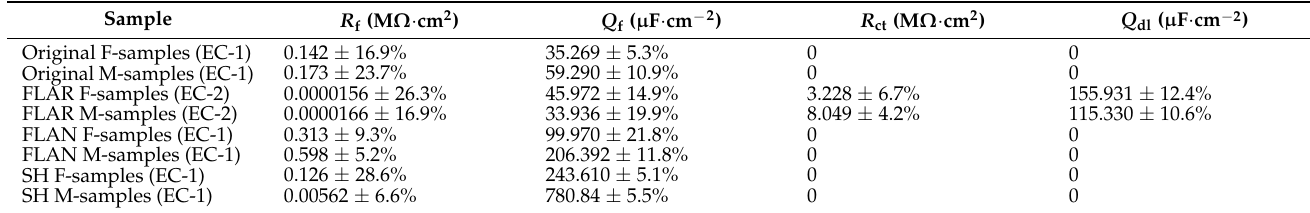
Table 5. Fitting results of EIS for 8 samples in 0.5 mol/L NaCl for 72